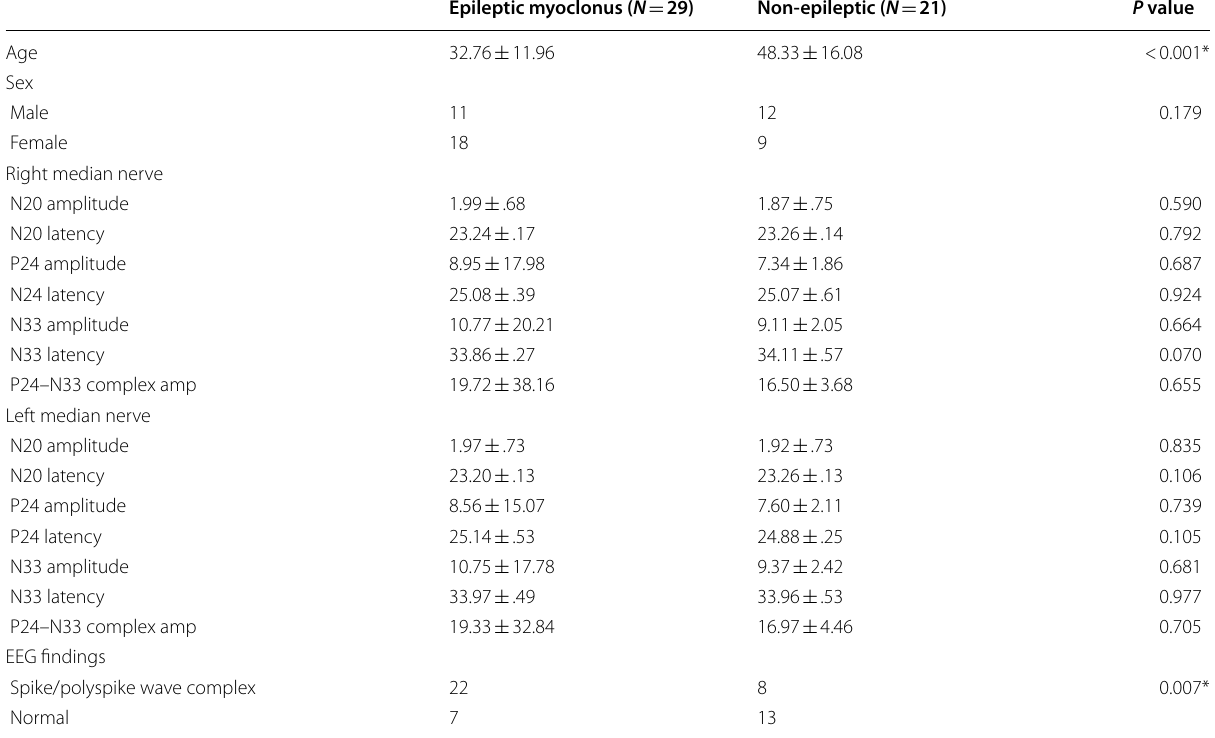
Epileptic myoclonus ( N =